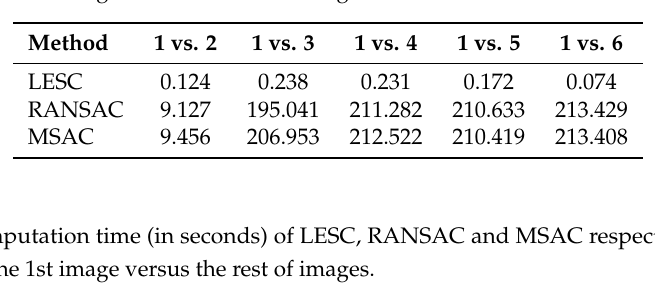
Figure 8. Viewpoint change for the structured scene by the Graffiti sequence. From ( a ) to ( e ) the degree of change ascends. Table 3. The computation time (in seconds) of LESC, RANSAC and MSAC respectively on the Bark sequence using the 1st image versus the rest of images.